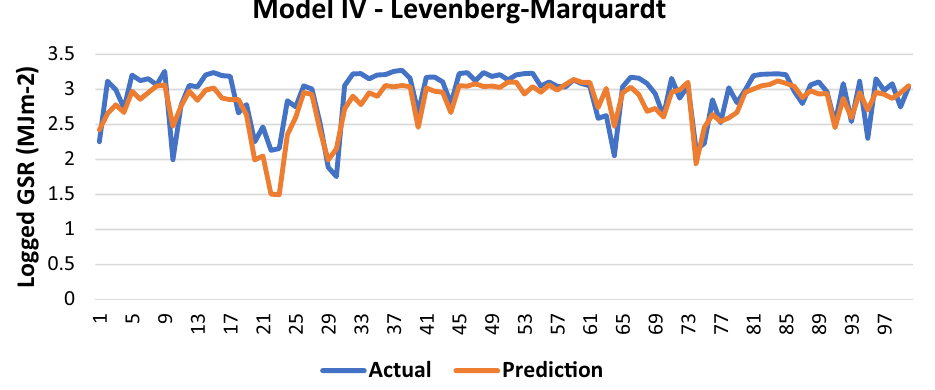
Figure 12. Graph of Actual and Predicted GSR (Model